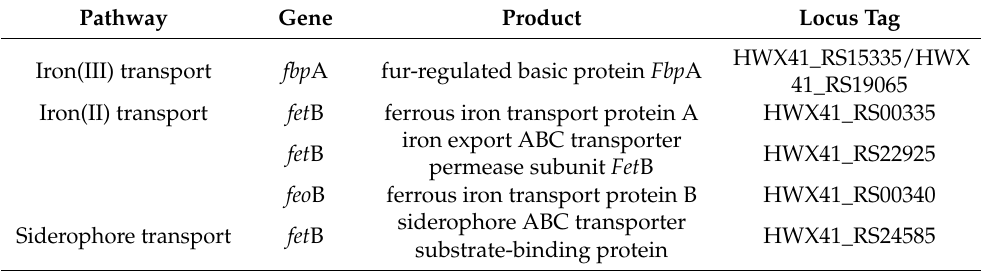
Table 4. Genes involved in iron transport and siderophore production.